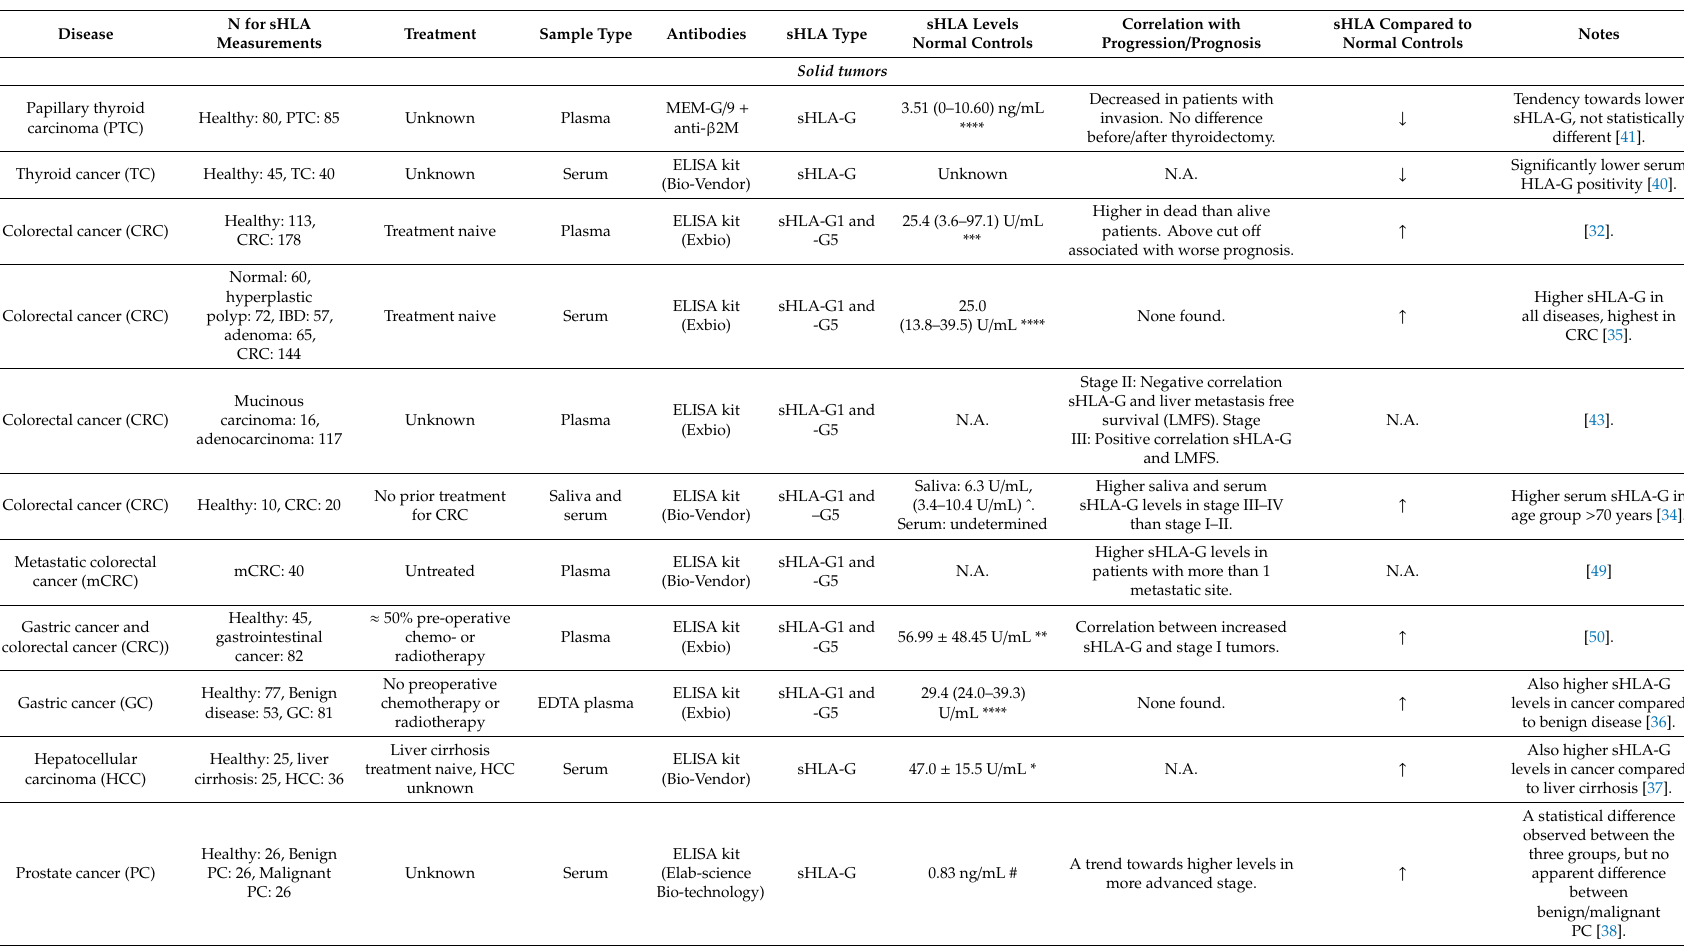
Table 2. Soluble HLA-G Molecules in Malignancy . Levels of soluble HLA-G molecules in various solid and hematological tumors. All studies measured sHLA levels by ELISA, unless indicated otherwise under Notes. * = mean ± SD, ** = mean ± SE, *** = median (range), **** = median (interquartile range), # = mean, $ = median ± SE, and ˆ = mean